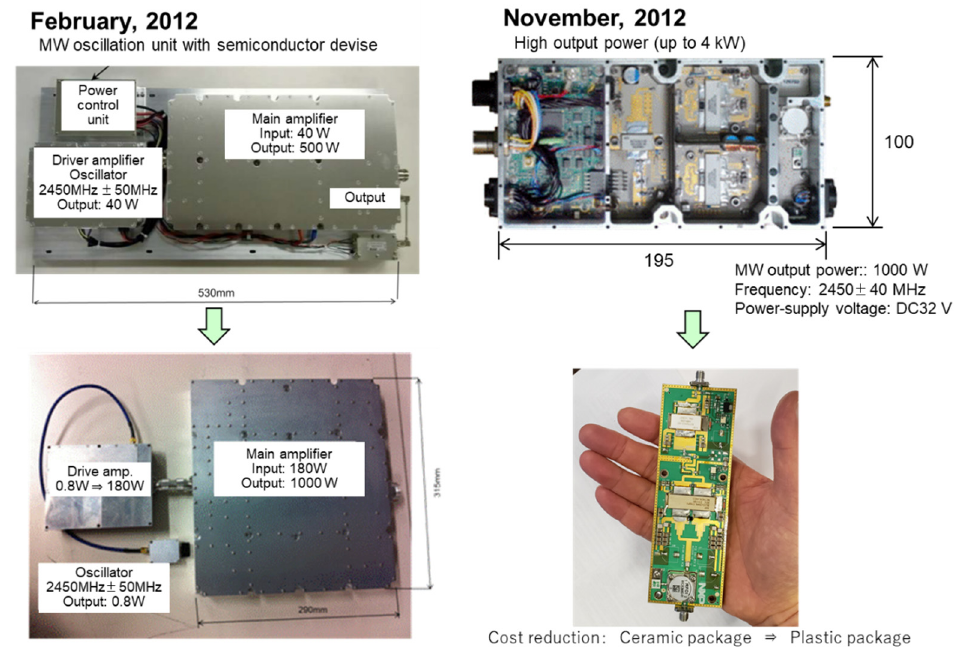
Figure 5. Size reduction of microwave oscillator.